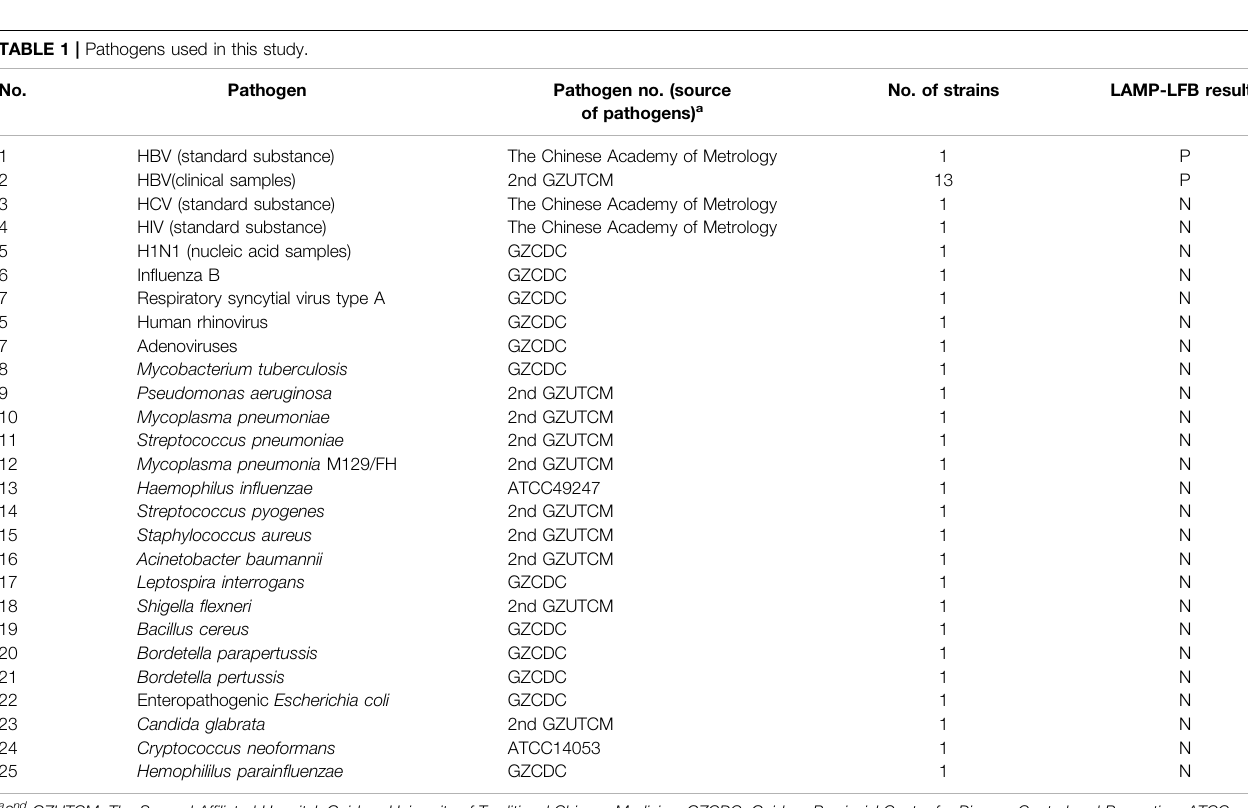
TABLE 1 | Pathogens used in this study. No. Pathogen Pathogen no. (source